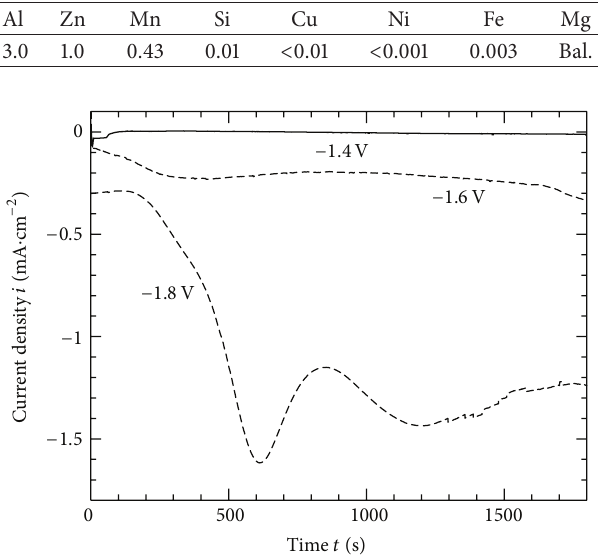
Figure 1: Current change during cathodic electrodeposition